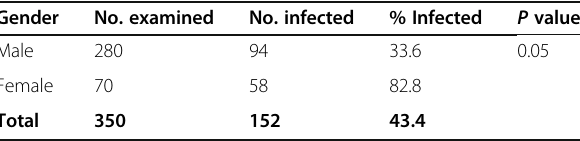
Table 1 Overall prevalence of Trichomonas vaginalis infection in relation to gender among inmates in Umuahia Prisons, Abia State